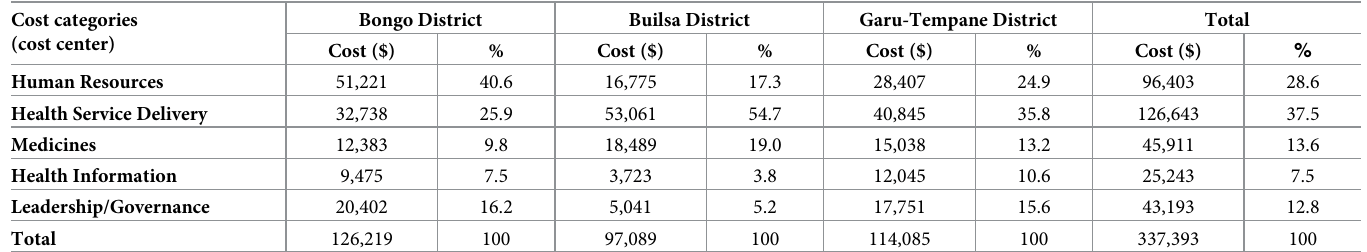
Table 6. Economic cost of implementing GEHIP program (2012–2014).